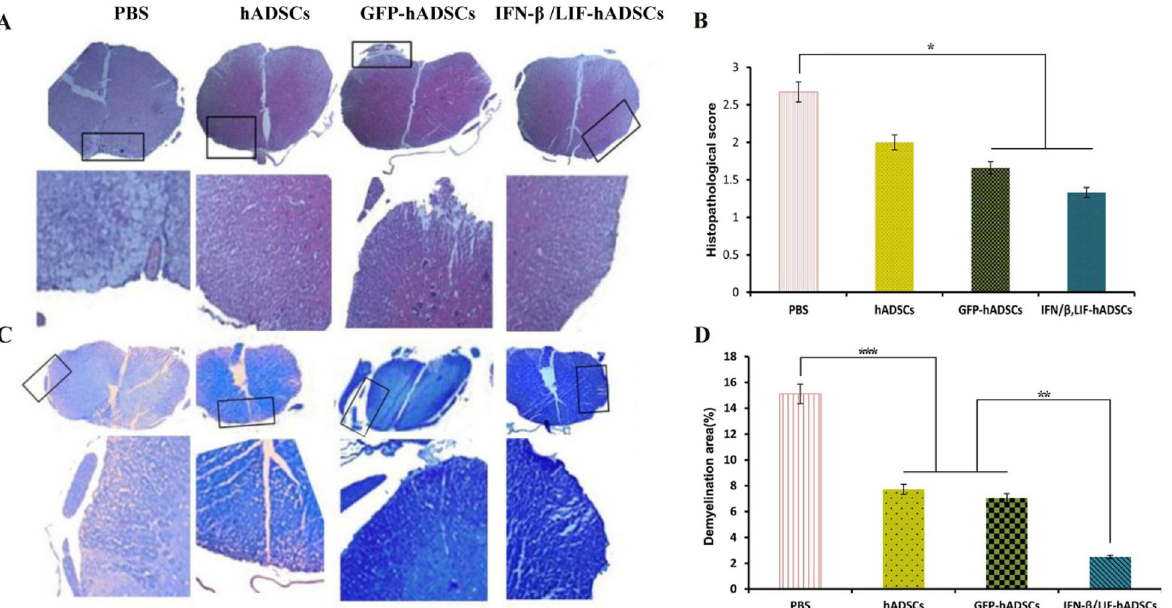
Figure 5. Histopathological cross-section of the spinal cord in different groups. Histopathological staining of spinal cord sections of animals 32 days after immunization for cell infiltration (H&E) and demyelination (LFB). A and B, respectively; 40X magnification for original images and 200X magnification for inserts. Quantitative cell diffusion (H&E) results were analyzed by Kruskal–Wallis and demyelination (LFB) results were analyzed by one-way ANOVA. B, ( P = . 037) D F3,8 = 63.038, P = 0.000007). (mean ± SEM, *P < 0.05, **P < 0.01, ***P < 0.001).